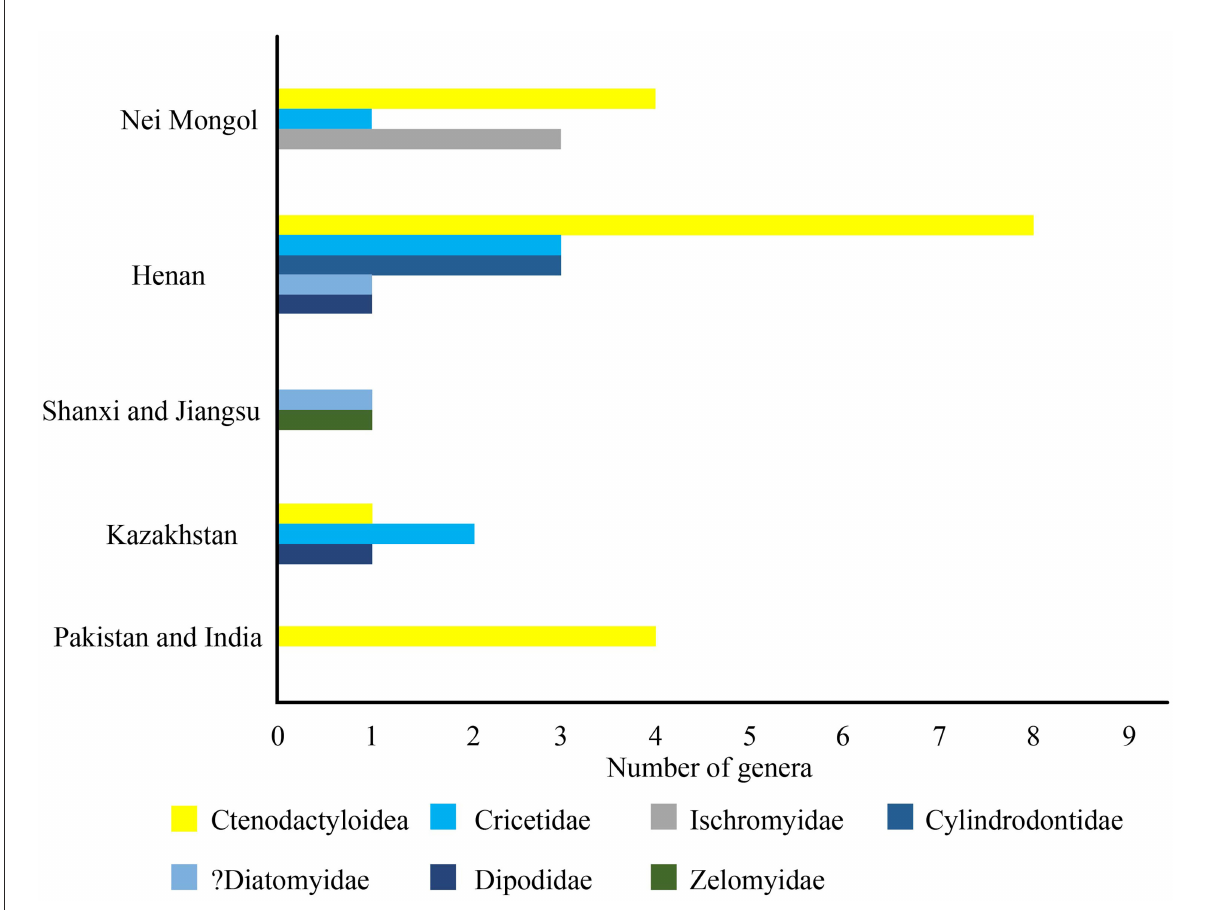
FIGURE4 Diagram of the Irdinmanhan rodent compositions in East, Central, and South Asia.